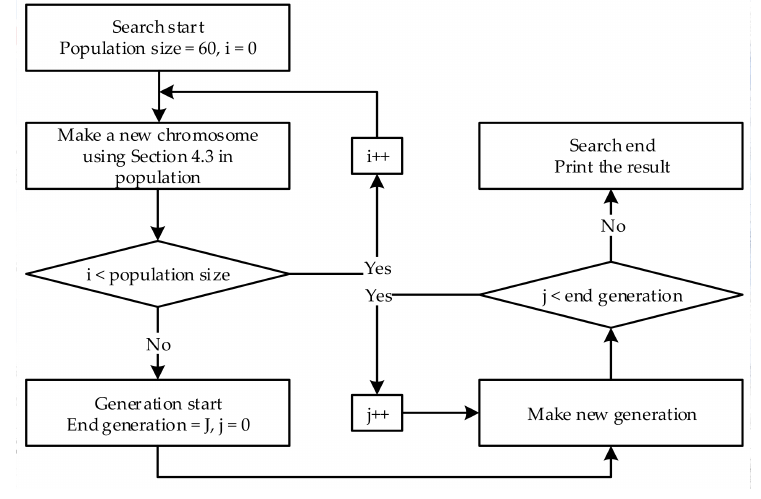
Figure 14. Flow of search process.